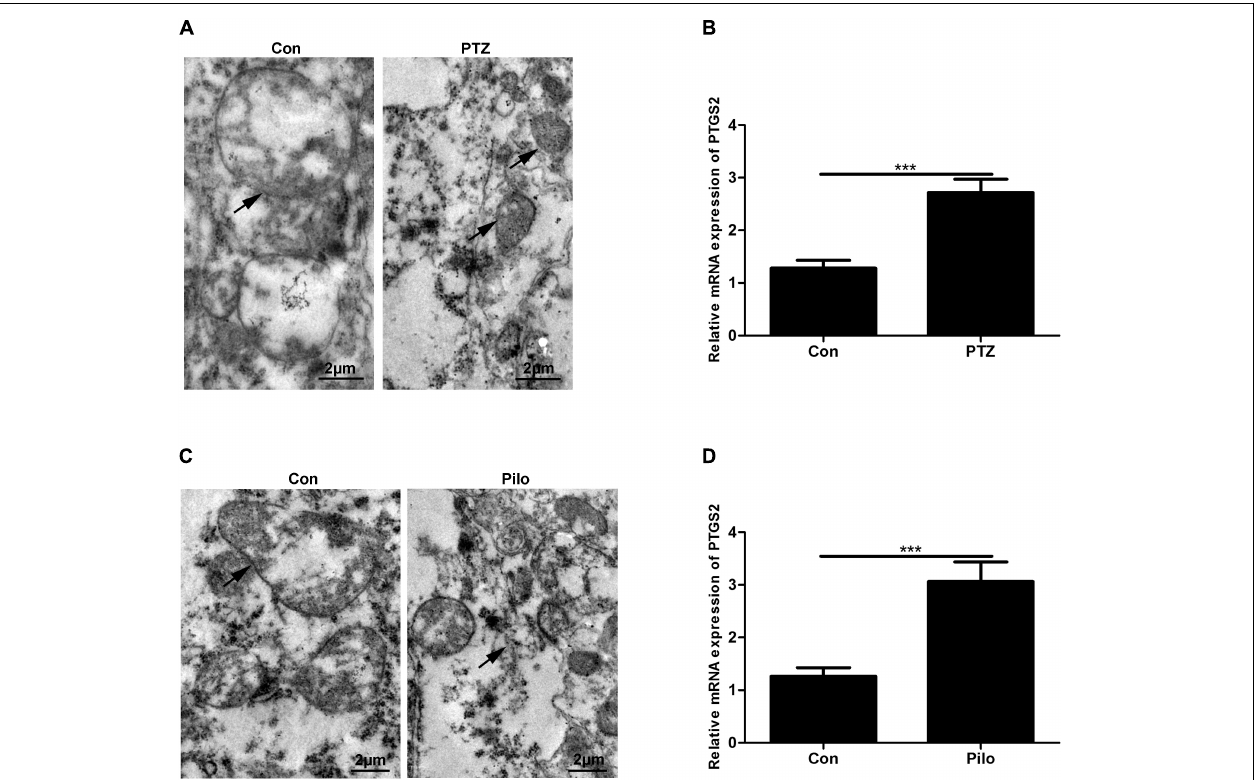
FIGURE 1 | Ferroptosis occurs in PTZ kindling and Pilo-induced seizures in mice. (A , C) Ultrastructure of neurons in PTZ- and Pilo-treated mice. Arrows indicate the representative mitochondria. (B , D) Quantitative analysis of PTGS2 mRNA in the hippocampus of PTZ- and Pilo-treated mice ( ∗∗∗ p < 0.001, n =